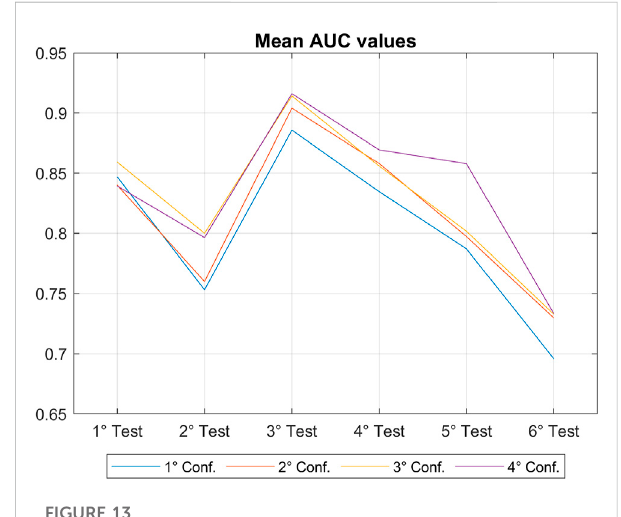
Mean AUC value for each test and con fi guration.